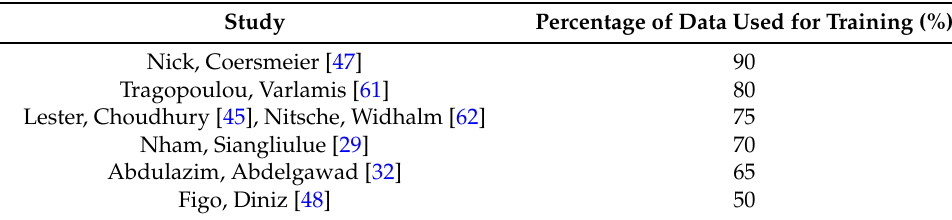
Table 5. Percentage of learning data used by various